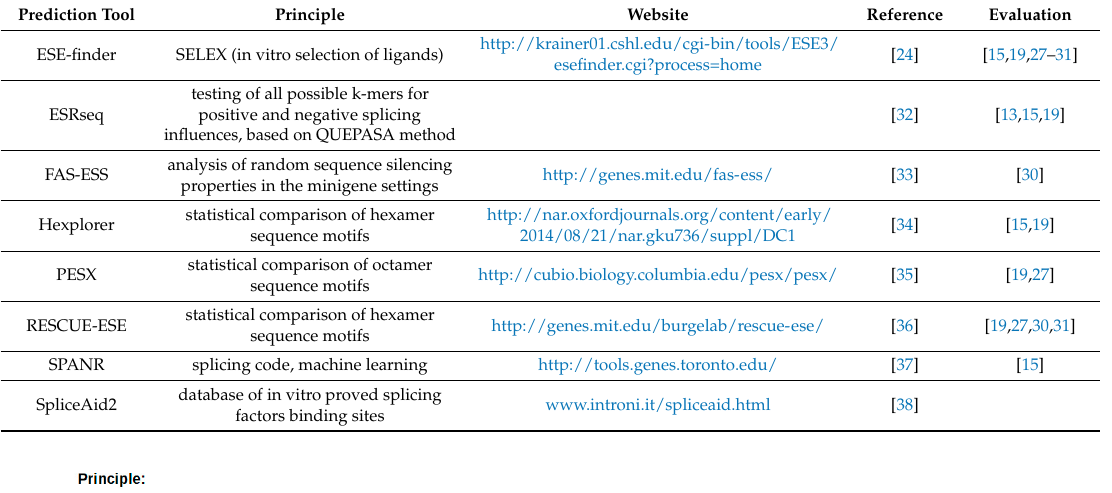
Table 1. Selected individual SRE-prediction tools.